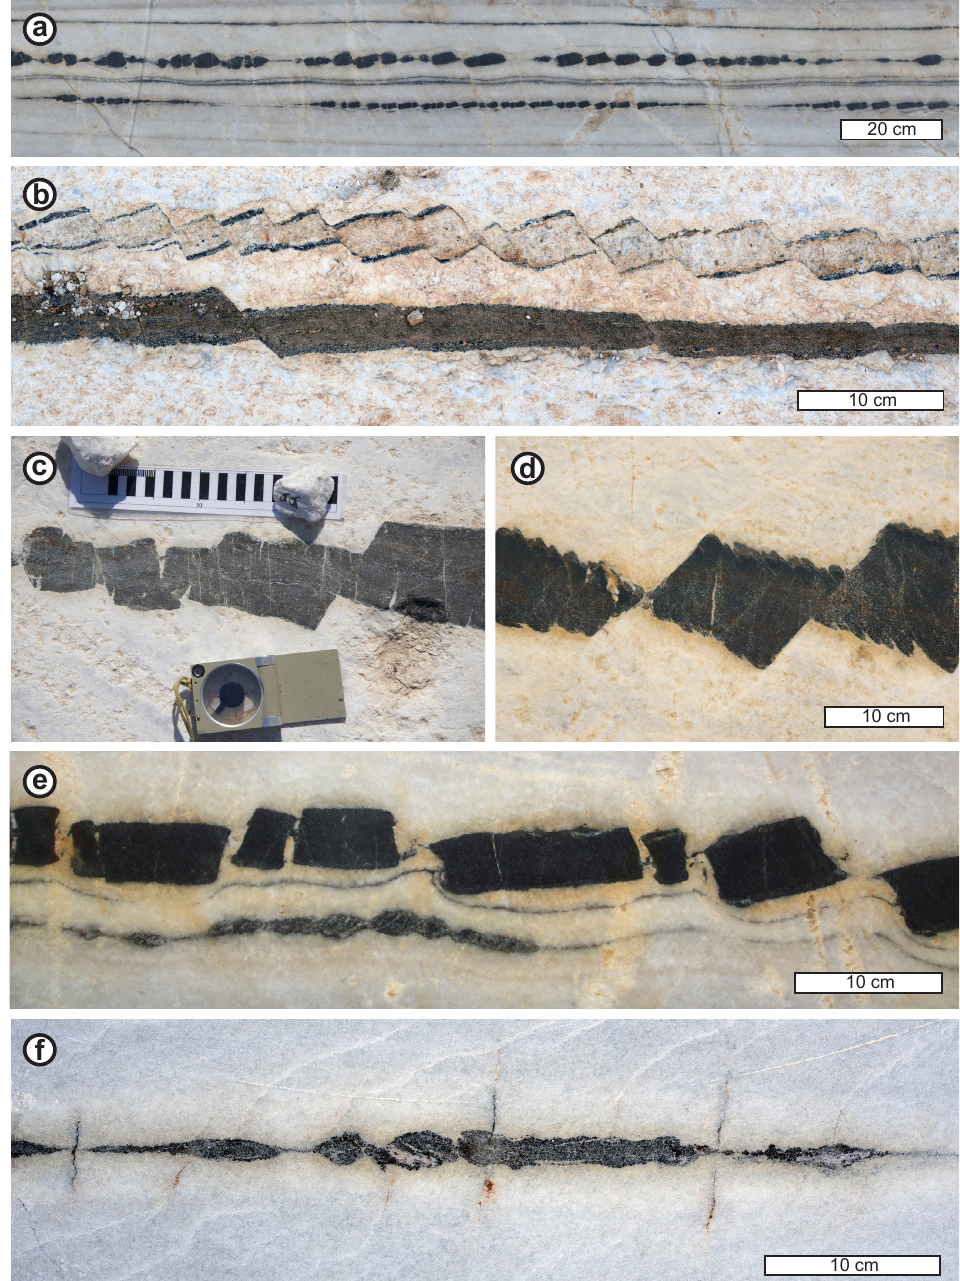
Figure 7. Brittle boudinage structures are best observed on quarry floors due to the generally high dips of the fracture planes. (a) Multiple layers of amphibole with two generations of boudin structures. The thin layers do not show any boudin structures while thicker layers boudinage in domino and torn boudins, overprinting long-wavelength pinch-and-swell boudins. The spacing of brittle boudins correlates with bed thickness, the lateral thickness variation results from older pinch-and-swell boudins. (b) Adjacent pegmatite and amphibolite layer with synthetic domino boudins. The length of the boudins in the amphibolite is exceptionally long. (c) Calcite- and chlorite-filled hairline veins crosscutting the shear planes of domino boudins. One of the fractures is an antithetic bending fracture. Usually the polarity of block rotation is very stable along a layer and antithetic fractures like this are rare in the study area. (d) Lobate amphibolite interface in the limb of an asymmetric fold crosscut and displaced by shear fractures. (e) Torn boudins with slightly concave faces S ib . A thin amphibolite layer highlights the deformation in the adjacent marble and shows the flow of marble into the interboudin zones. (f) Chlorite-filled mode-I hairline veins extending from the amphibolite layer into the surrounding